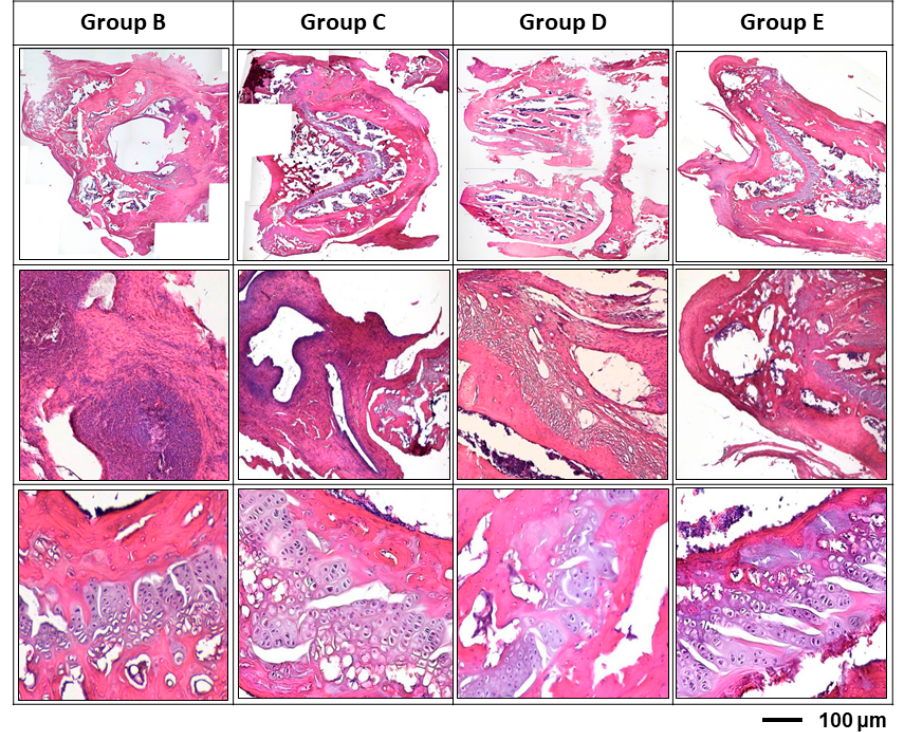
Figure 8. Histological examination of different treatment modalities for osteomyelitis rats after 12 weeks’ infection. After inoculation of Staphylococcus aureus , tissue necrosis with active inflamma- tion and even biofilm formation was clearly demonstrated in all groups; while, the biofilm formation was found both the at the surface of the inserted pin and the inner surface of bony trabeculae. Group B: titanium implant only; Group C: titanium implant with hydrogel; Group D: titanium implant with hydrogel and gentamicin; Group E: titanium implant with vancomycin. All implants were loaded with 108 CFU/5 mL Staphylococcus aureus to promote infection. Table 2. T Semi-quantitative histo-morphological evaluation of osteomyelitis by histopathological osteomyelitis evaluation scoring system [Histopathological Osteomyelitis Evaluation Score (HOES)]. Group B